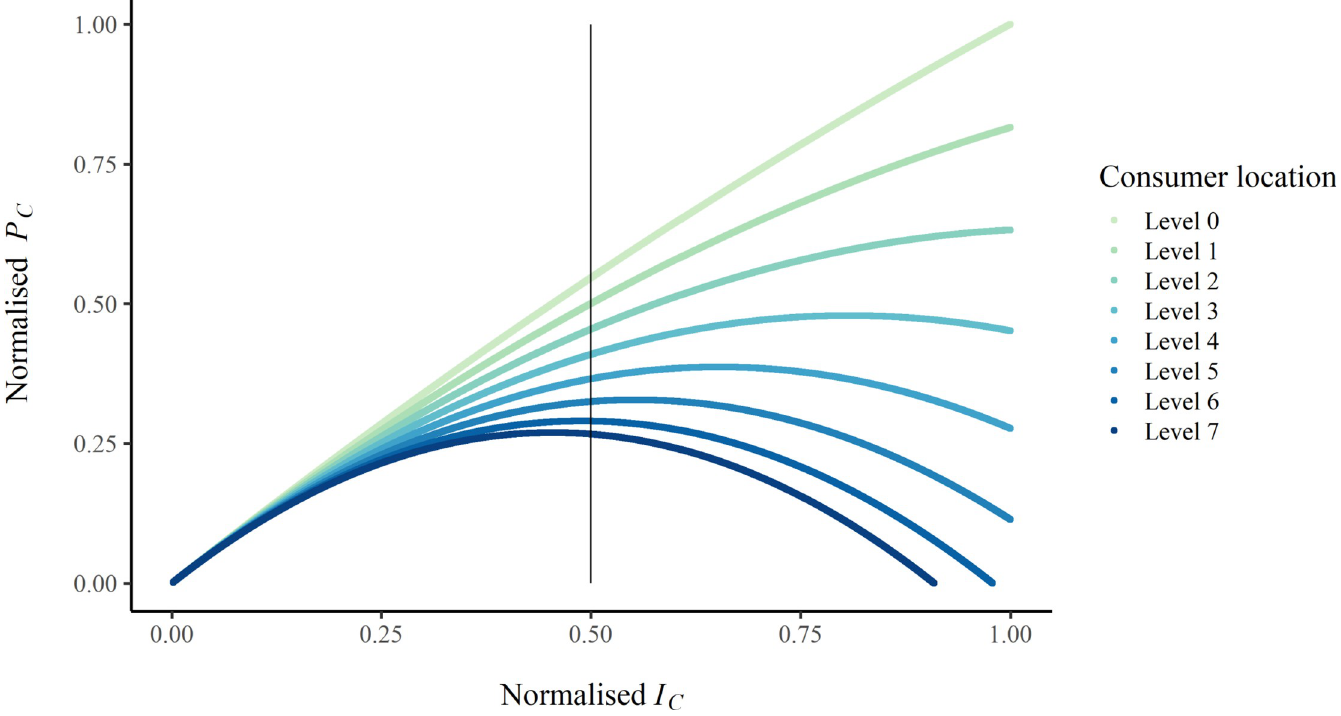
Fig 7. The relative final power of consumers ( P C ) at each level of the ‘fully branched’ network, as related to the relative resource flow to each consumer ( I C ). The vertical black line denotes the relative resource flow associated with network-wide maximum final power. Each series represents the relative final power consumption of consumers at that level in the network, where Level 0 is the consumers closest to the resource, and Level 7 are the consumers furthest from the resource in the network. As the resource flow increases across the network, the more distant consumers experience disproportionally greater frictional losses and therefore power losses, while consumers closer to the resource continue to increase in power. Values have been normalised by the maximum consumer final power and maximum consumer resource flow, which preserves relative differences. A copy of the figure with raw data is included in S3 Fig.